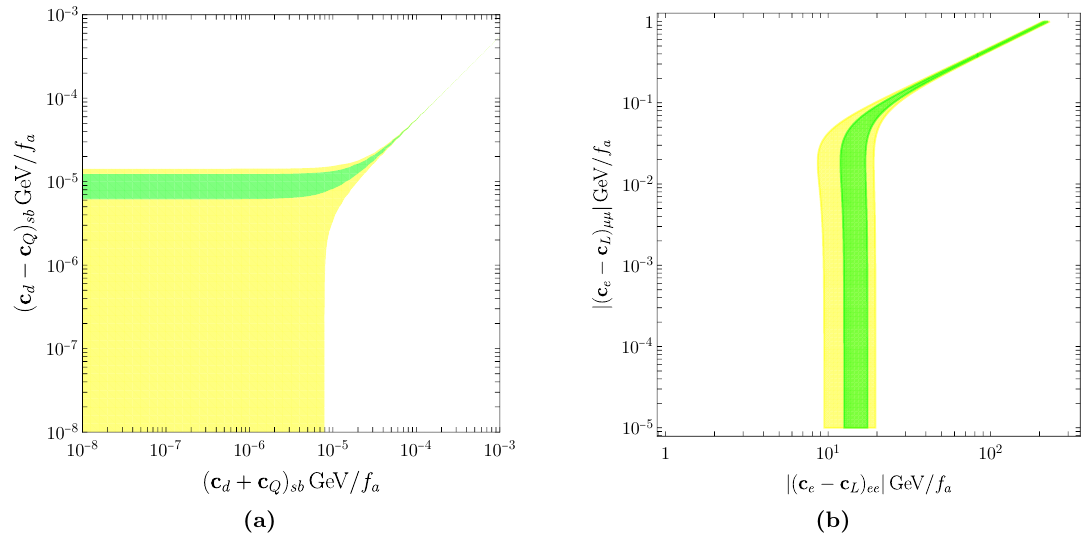
Figure 3. ALP heavier than B mesons. In figure 3a, ( c d ± c Q ) sb /f a parameter space allowed by B s meson oscillation constraints, at 1 σ ( 2 σ ) in green (yellow). This plot is symmetric with respect to any of the axes for negative values of the coordinates. In figure 3b, the parameter space for the com- binations ( c ) and ( c ) that solve the R anomaly in figure 2 for the maximal e − c L ee /f a e − c L µµ /f a K allowed value ( c + c ) = 10 − 5 GeV − 1 . The ALP mass is fixed to m = 10 GeV in both Q d sb /f a a